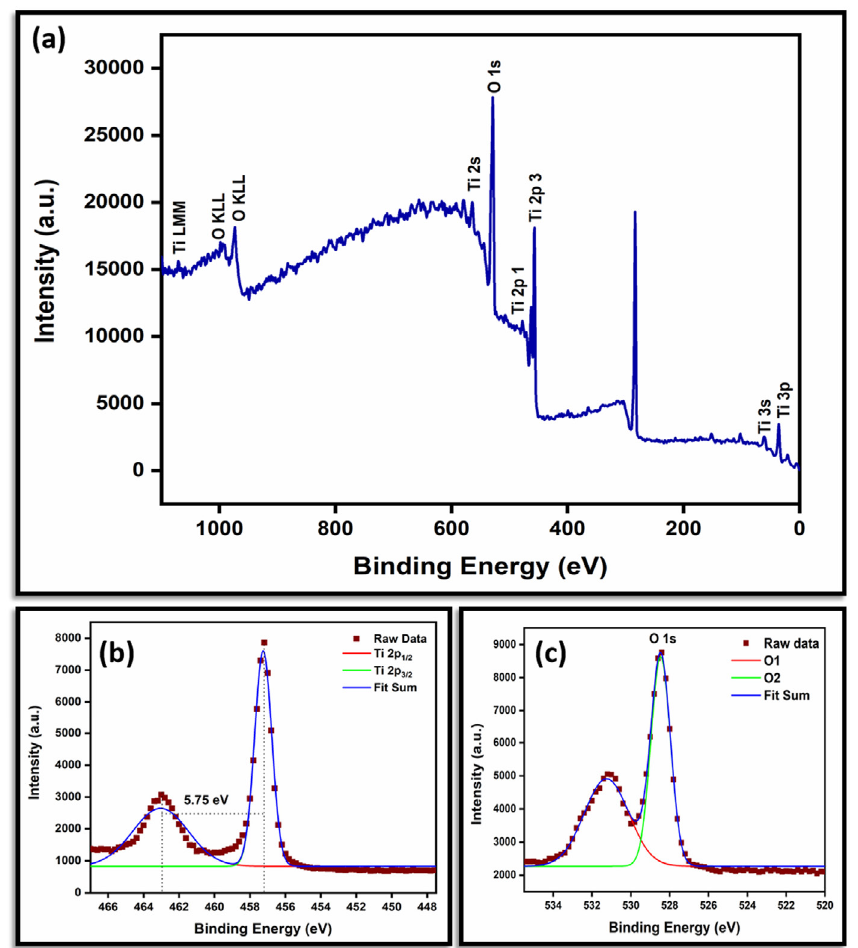
Fig. 5. FTIR spectra of TiO